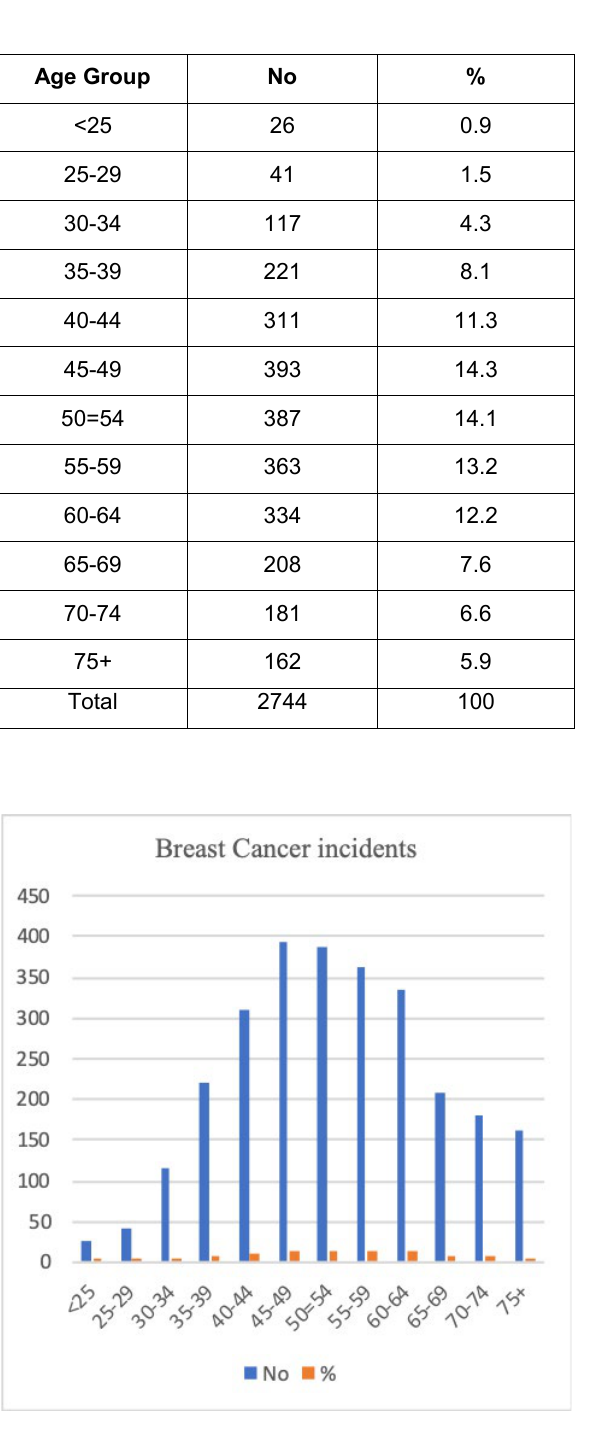
Figure 4. Breast Cancer Incident rates for Female Delhi, 2012 Age standardized incidence rates of various registries in India has been compared, as shown in Figure 5.